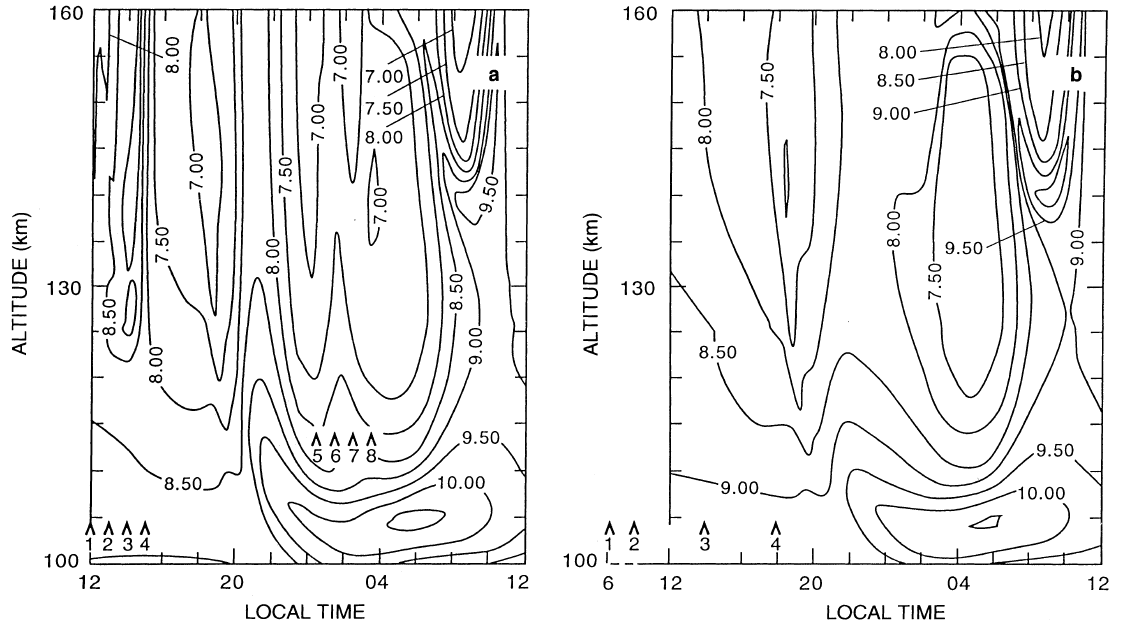
Fig. 13a, b. Height versus contours log [Fe + ] at 9 (cid:176) latitude with meteor shower. Compare with undisturbed contours in Fig. 10b. 10 meridional and zonal winds and electric field. a perturbed by Labelled arrows are defined in the ) 2.0 mVm ) 1 magnetic storm-induced pulse; b perturbed by noontime